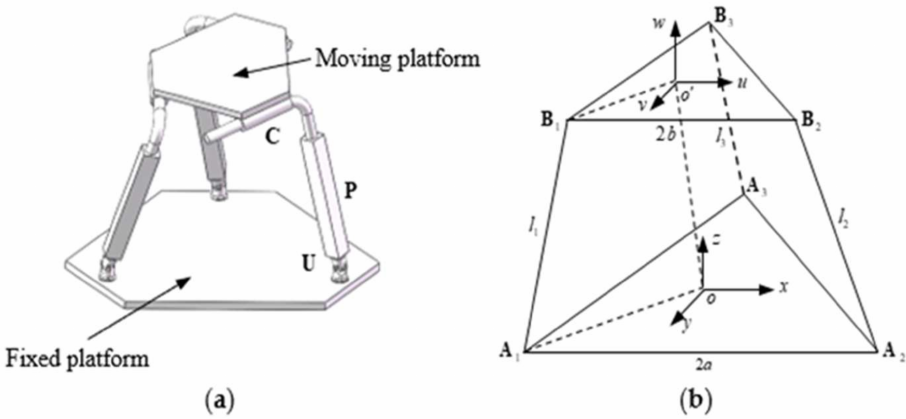
Figure 1. 3-UPC type parallel prototype manipulator ( a ) structure configuration model, ( b ) parameters with coordinate